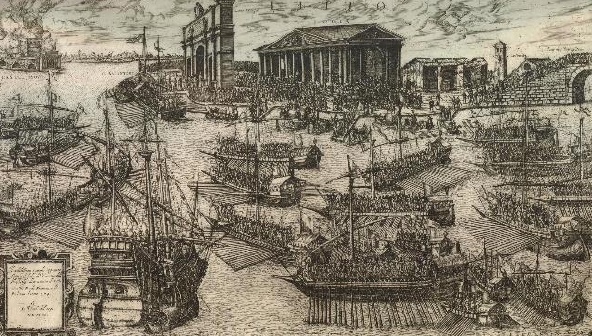
Figure 1. G.D.M. Master, The arrival of Henri III of France at